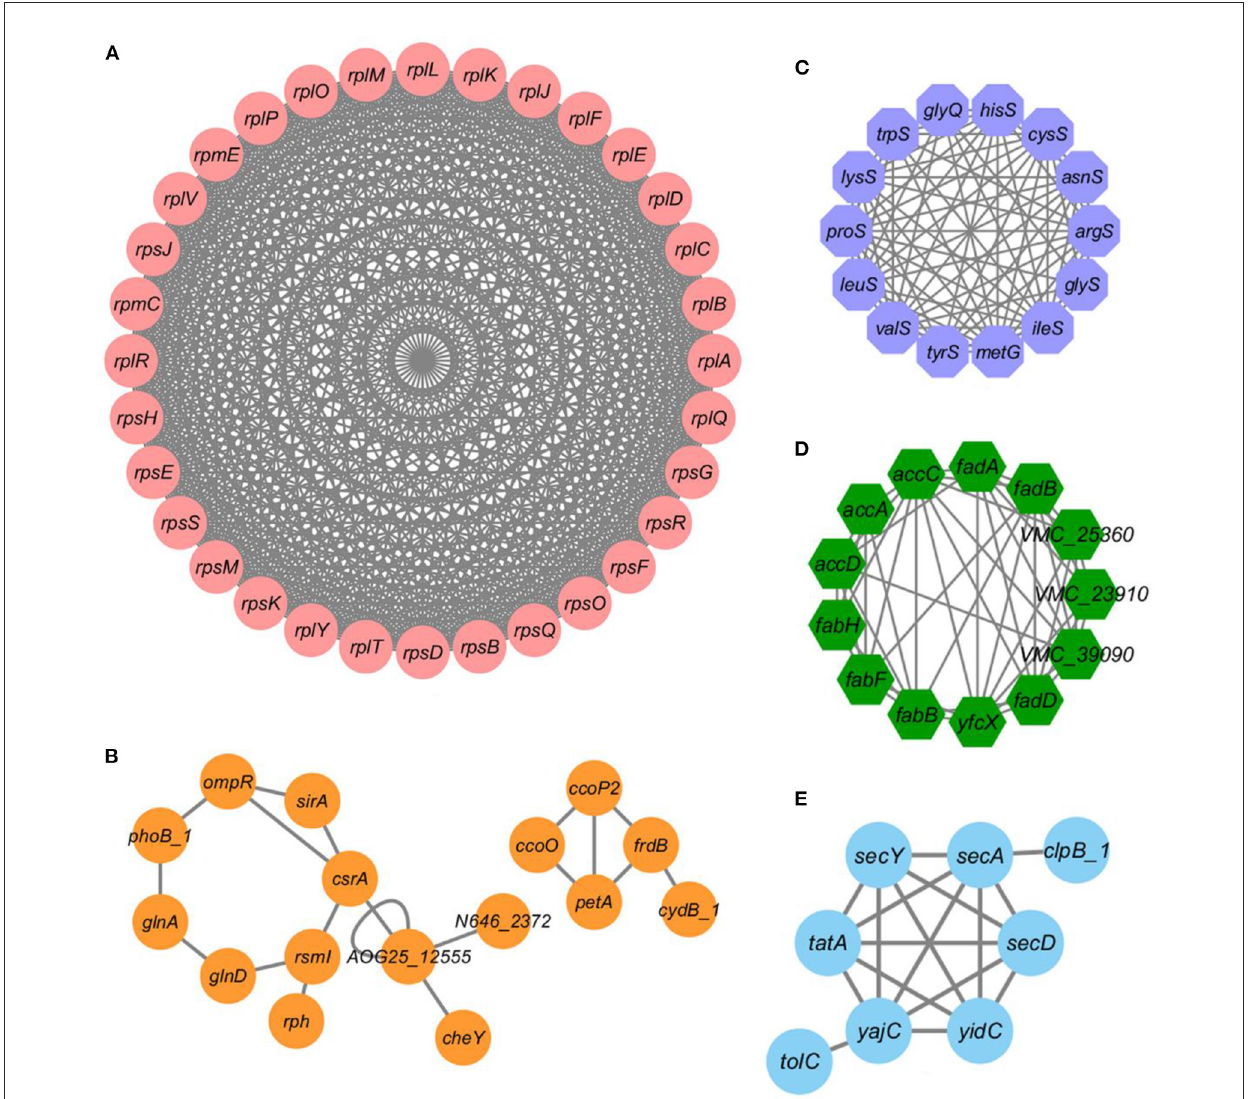
FIGURE5 Protein-protein interaction networks of acetylated proteins under bile salt stress in V. alginolyticus . PPI networks of acetylated proteins were analyzed using the STRING combine with Cytoscape software. (A) ribosomes, (B) two-component system, (C) aminoacyl-tRNA biosynthesis, (D) fatty acid metabolism, and (E) bacterial secretion system.